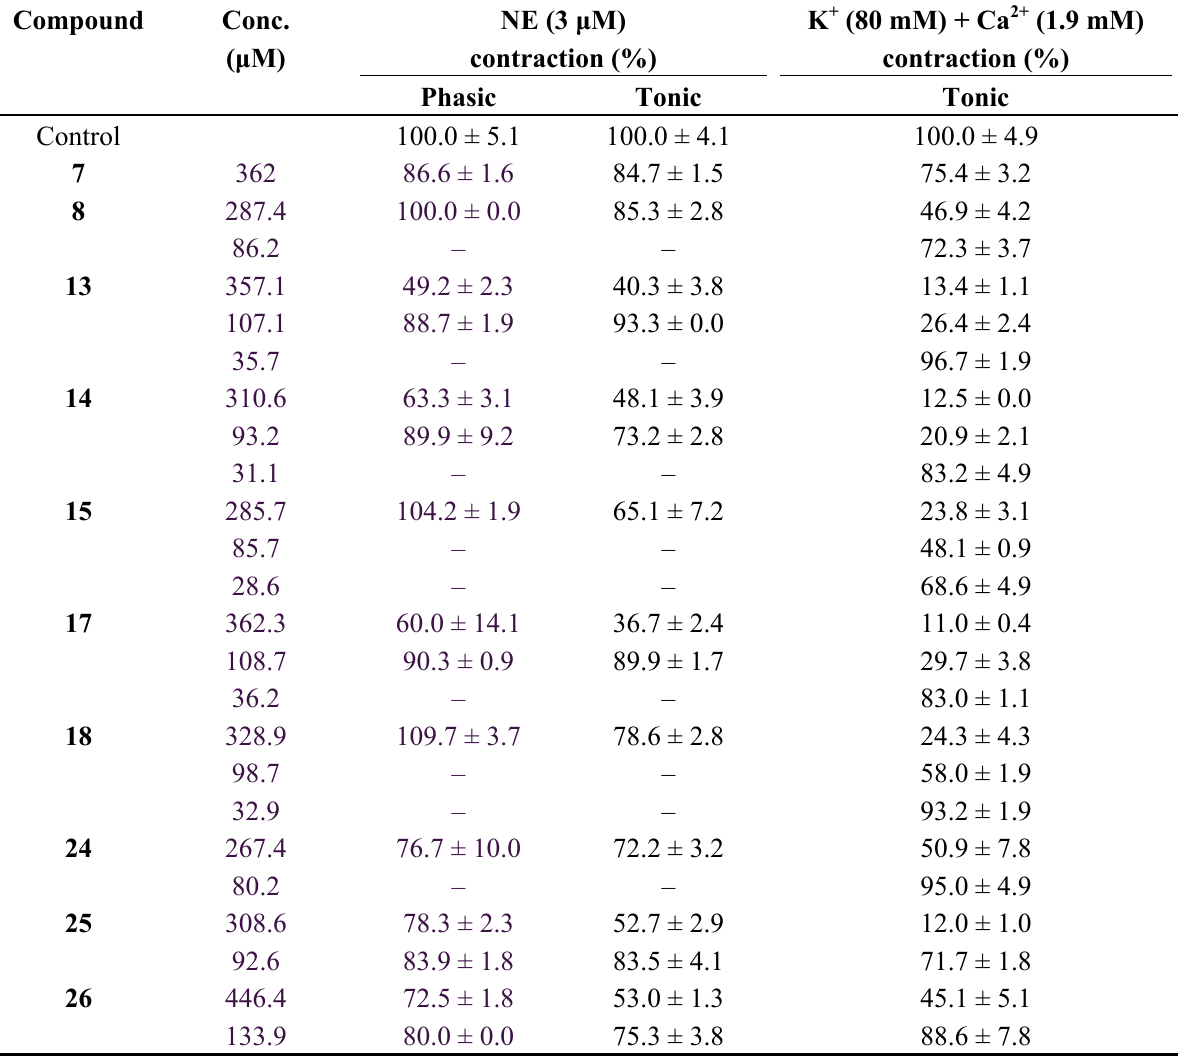
Table 2. Inhibition of KCl, norepinephrine-induced contraction of rat aorta by compounds 7 , 8 , 13 – 15 , 17 , 18 , 24 – 26 .